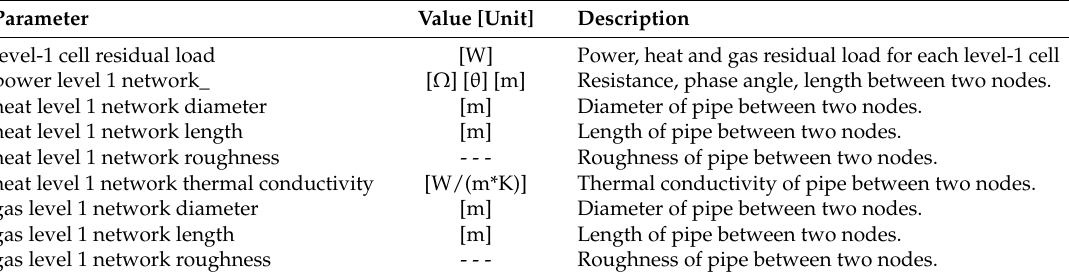
Table 3. Prepared input data files in